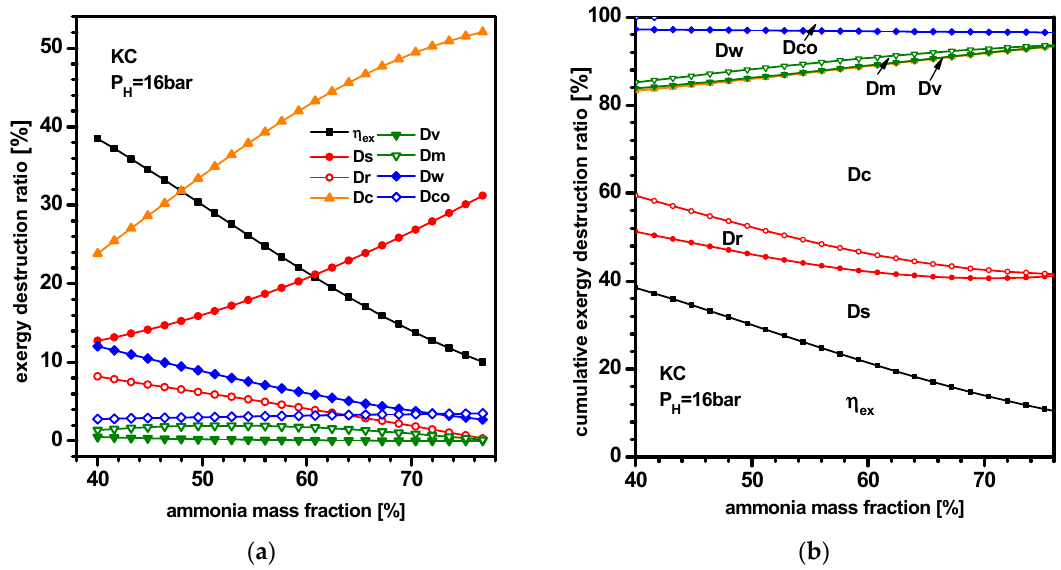
Figure 10. Dependence of ( a ) separate and ( b ) cumulative ratios of exergy consumption on the ammonia mass fraction for P H = 16 bar in the KC.